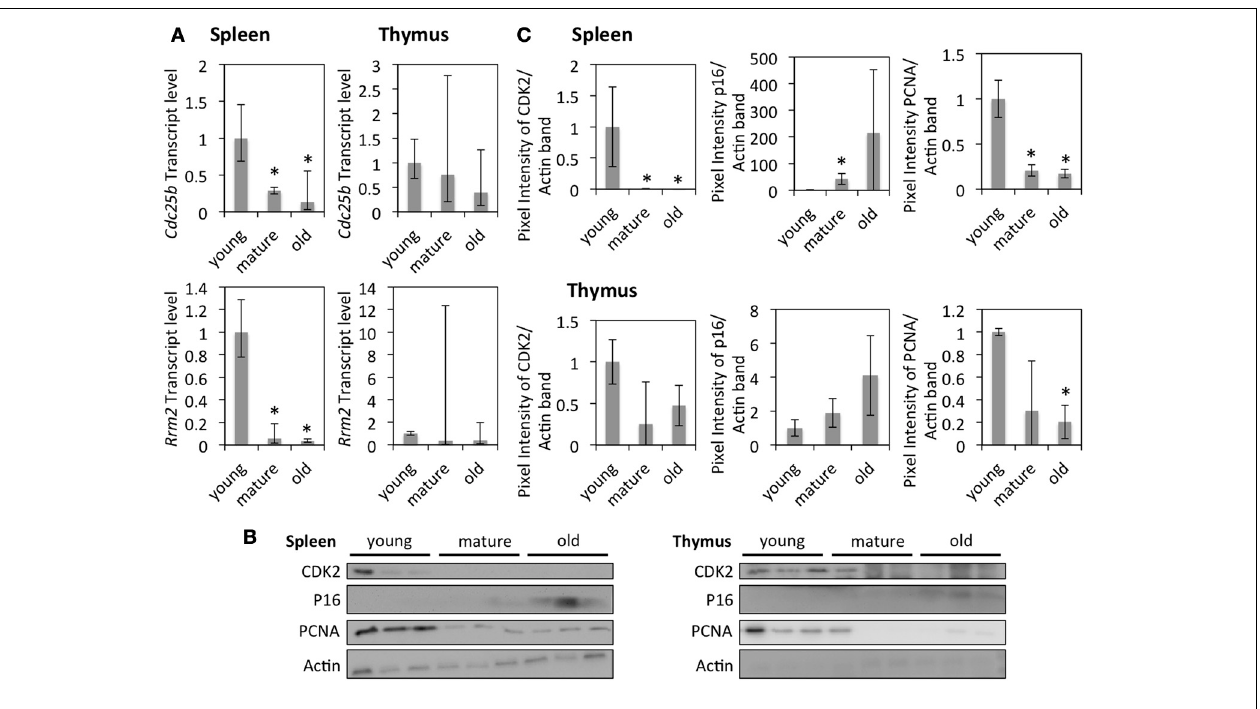
FIGURE 2 | The effects of age on cell cycle and DNA replication in the spleen and thymus of rats. (A) Fold changes of mRNA expression as measured by qRT-PCR standardized to gene expression in young animals. The bars represent mean ± 95% confidence interval. (B) Western blots showing protein levels of CDK2, p16, and PCNA. (C) Protein expression